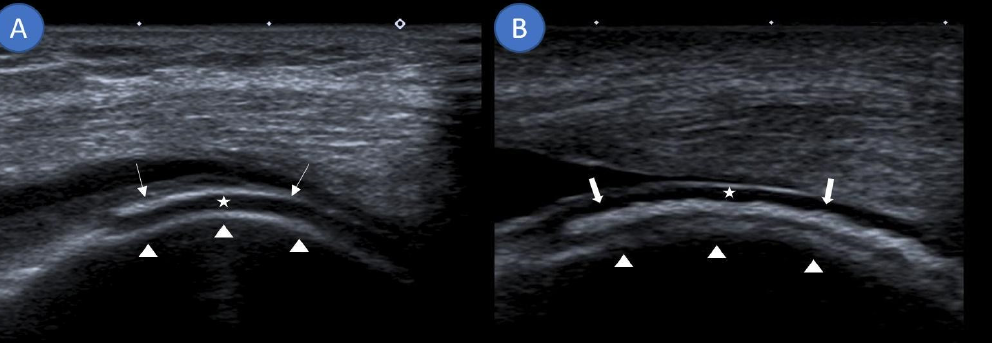
Figure 1. Differentiating the double contour sign from an intracartilaginous hyperechogenicity. ( A ) Sagittal ultrasound demonstrating monosodium urate deposits (arrows) as a hyperechoic band running parallel to the echo-free hyaline cartilage (star) at the suprapatellar knee joint. Together with the hyperechoic margin created by the femur (arrow heads), this forms the double contour sign. ( B ) Sagittal ultrasound along the lateral femoral condyle showing an intracartilaginous hyperechogenicity (thick arrows) visualizing calcium pyrophosphate deposits consistent with the intracartilaginous hyperechogenicity sign.